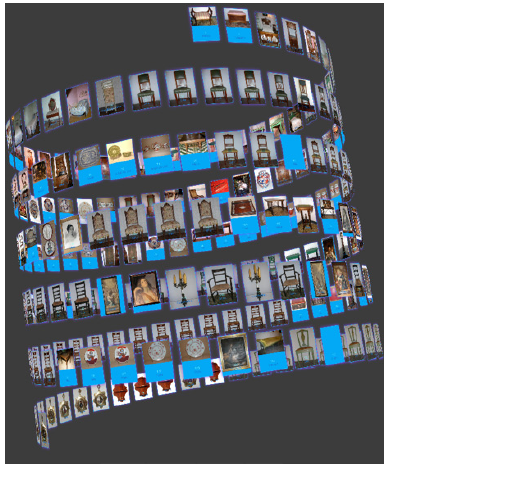
Table 3. Description of the stress test steps for Test Navigation and Test Search.